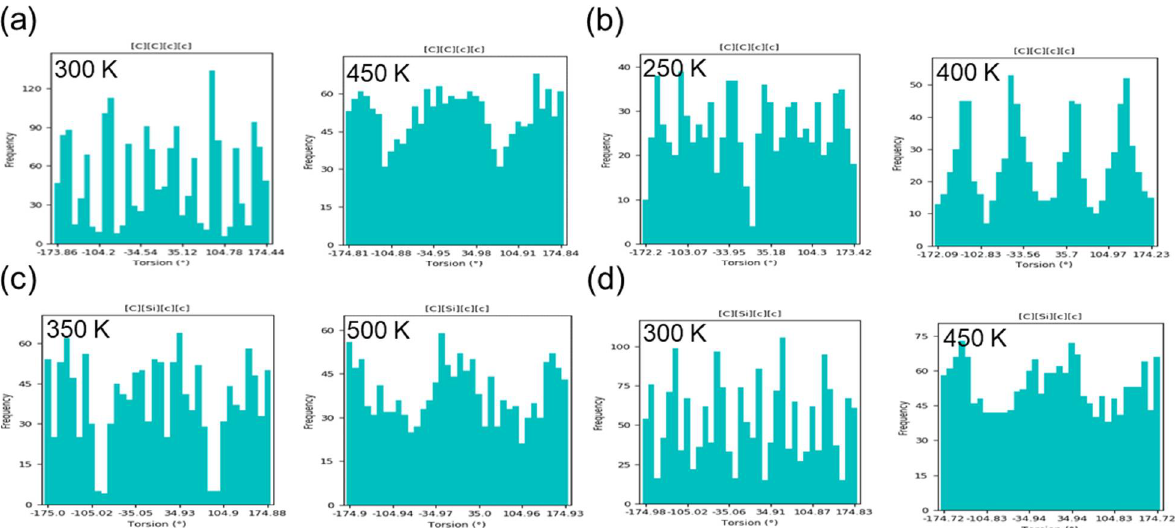
Figure 8. Histogram plots to examine the distribution angle values for an individual torsion for: ( a ) BADCy, ( b ) LECy, ( c ) SiCy-3, and ( d ) SiMCy.